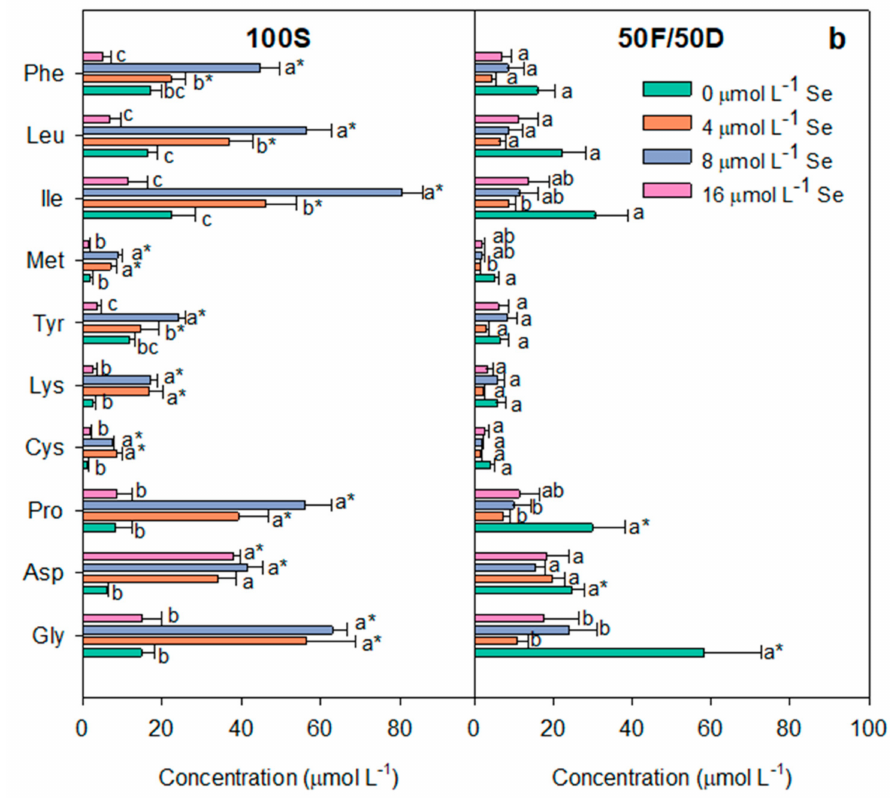
Figure 5. Effects of different selenium concentration (0, 4, 8, and 16 µ moles L − 1 ) and two types of irrigation water (100S or 50F/50D) on: ( a ) major amino acids and ( b ) minor amino acids in lettuce. The data are presented as the treatment means ( n = 6). Different lower-case letters indicate significant ( p ≤ 0.05) differences between different dosages of selenium combined with the 100S treatment and different capital letters indicate significant ( p ≤ 0.05) differences between different dosages of selenium combined with the 50F/50D treatment. * denotes significant differences ( p ≤ 0.05) between plants submitted to 100S treatment and those irrigated with 50F/50D for the same Se